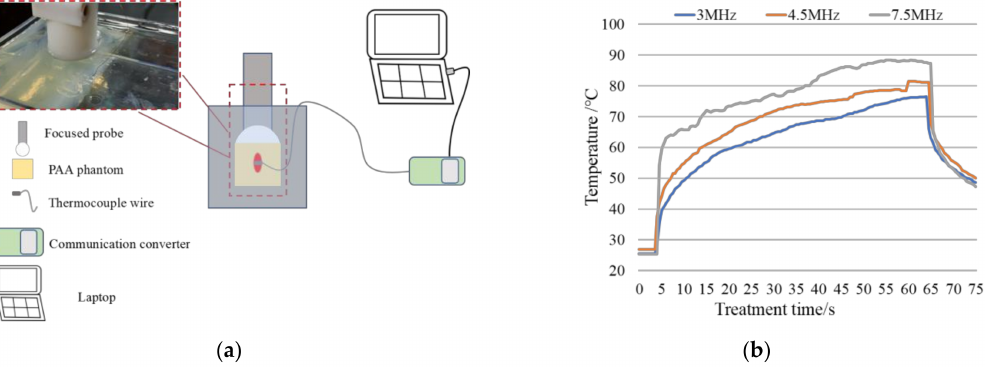
Figure 4. Protein heating rate treatment experiment: ( a ) experimental platform; ( b ) protein heating rate measurement